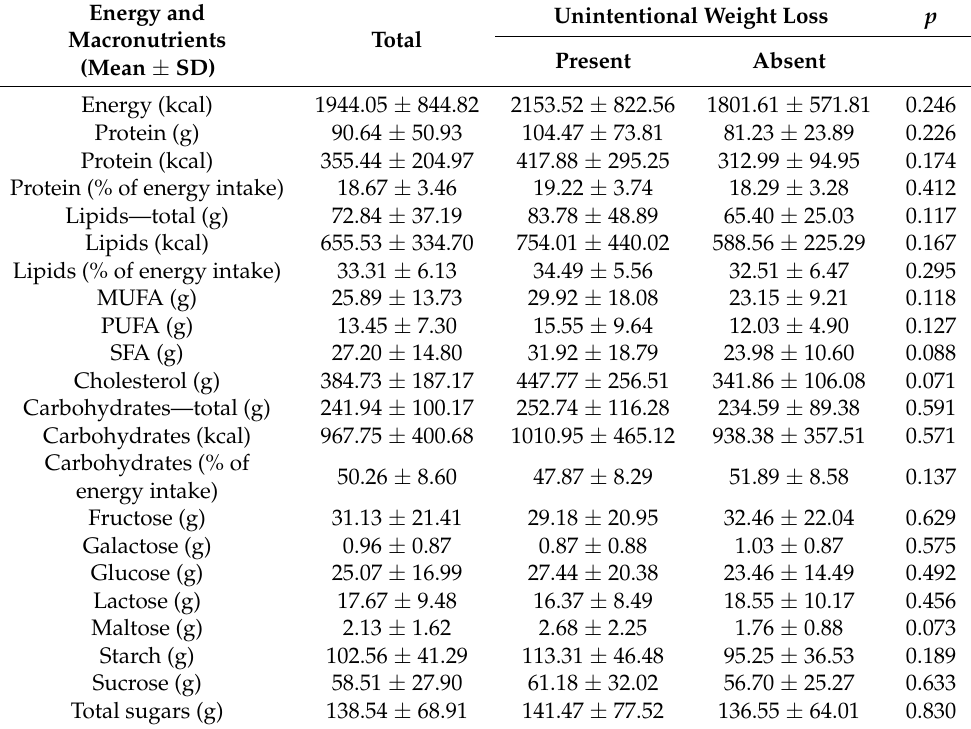
Table 4. The average daily consumption of energy and macronutrients in the study group (total and with respect to the presence of weight loss).